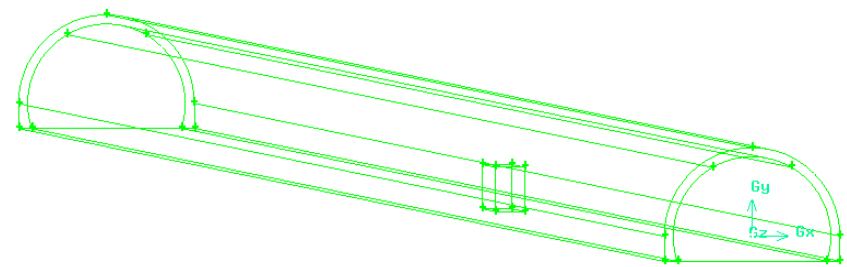
Figure 10. Numerical model for fire simulation.